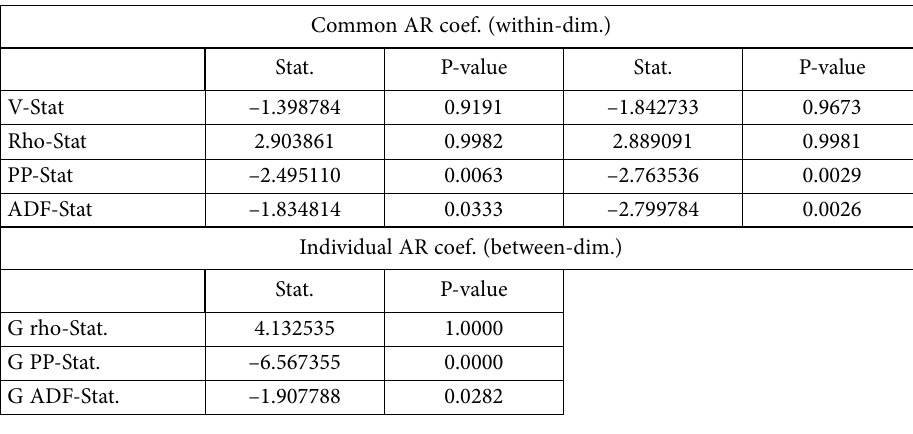
Table 6. Pedroni test (source: author’s own calculation) Common AR coef. (within-dim.) Stat. Stat.